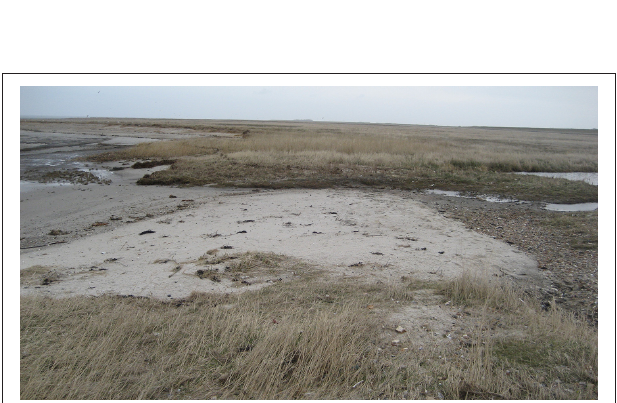
FIGURE 4 | Photograph of the overwash breach, taken on 15 March 2014 (by Julian Bisgwa).